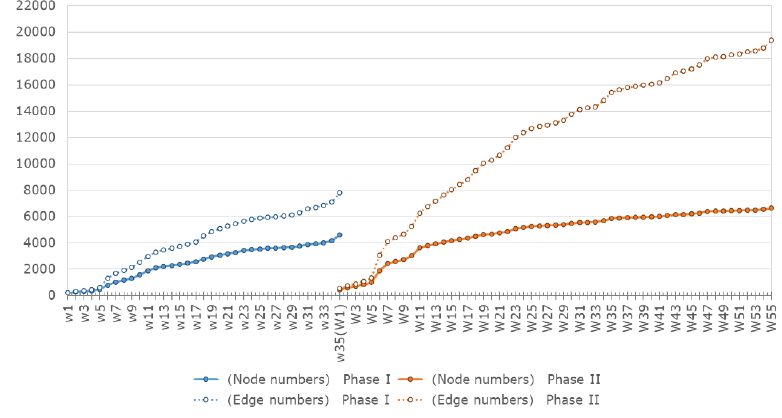
Figure 2. The number of nodes and edges. Note: in the oriental axis, 𝑤 𝑖 and 𝑊 𝑖 are the labels for the time windows of Phase I and Phase II, respectively.